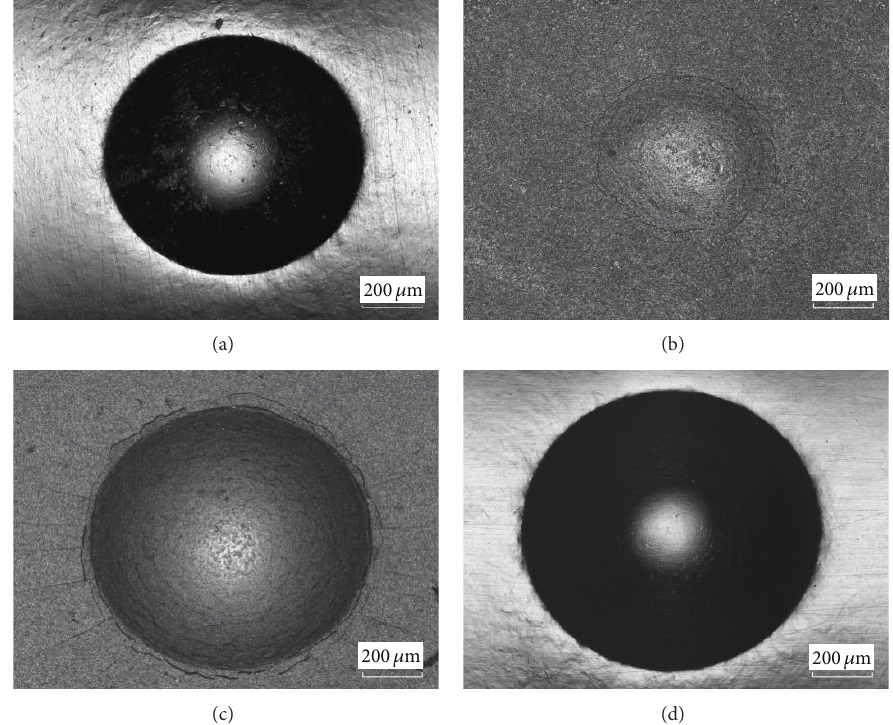
Figure 5: Morphologies of the indentations: (a) indentation on UCN under 100 N, (b) indentation on CN under 62.5 N, (c) indentation on CN under 187.5 N, and (d) indentation on CNP under 187.5 N.